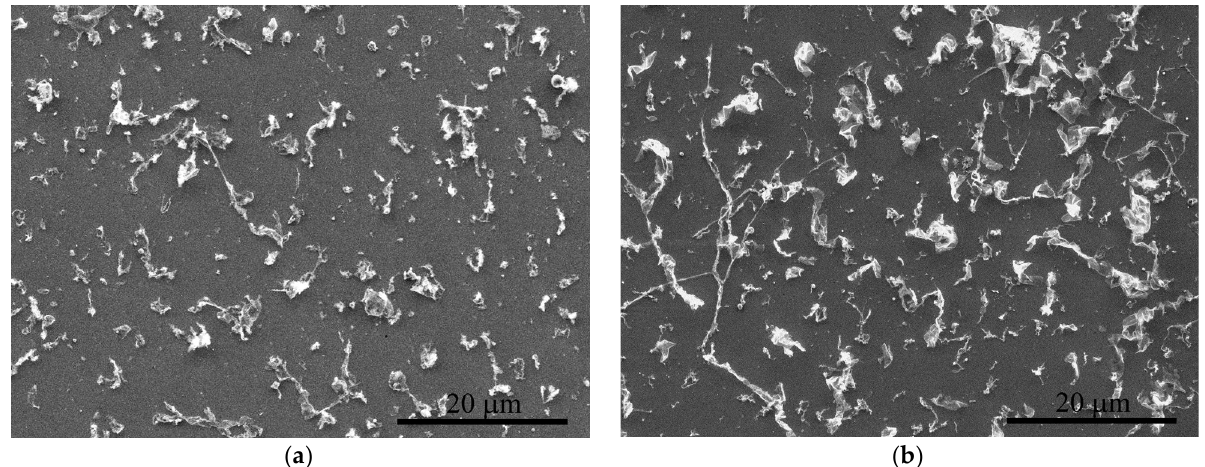
Figure 3. SEM images of characteristic printed regions after single ( a ) and triple ( b ) laser exposure.